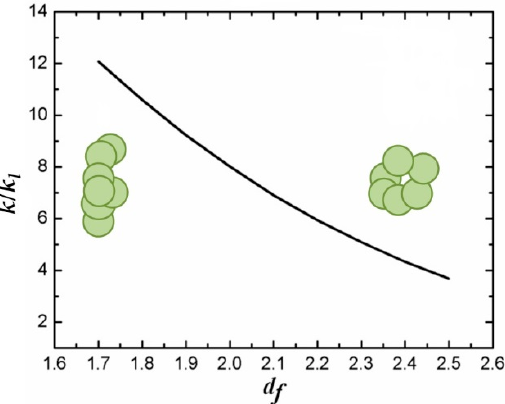
Figure 12. Influence of the fractal dimension on the thermal conductivity enhancement in TiO 2 -based NFs using Equation (13) and the parameters described in [220]. Adapted with permission from [220], Copyright 2014, Wiley and Sons.